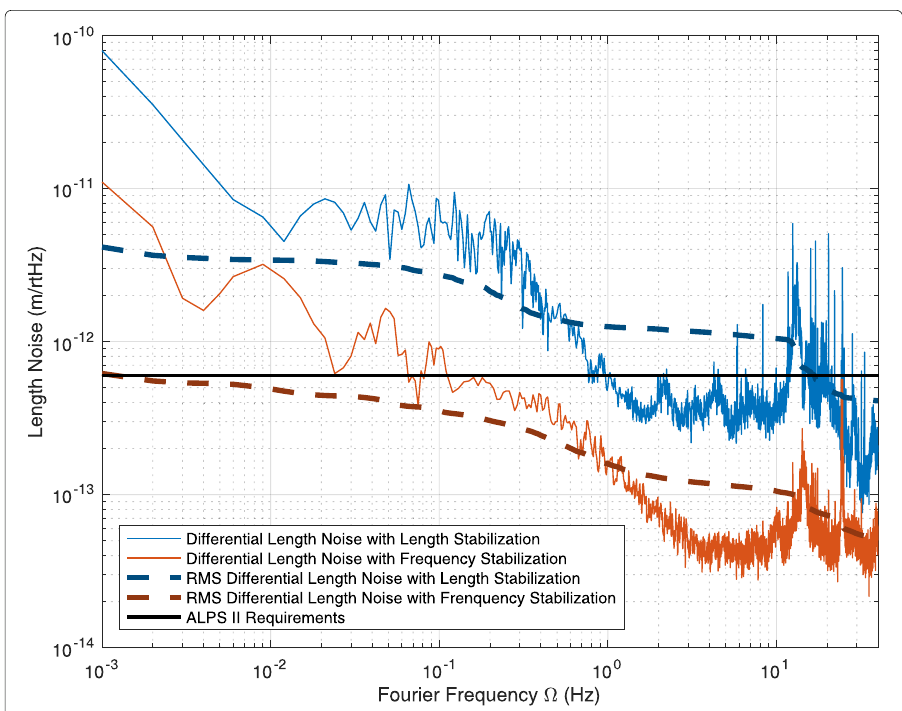
Fig. 4 Out-of-loop measurement. Beatnote frequency measurement for the length (solid blue trace) and frequency (solid red trace) feedback and corresponding RMS filtered by the infrared RC cavity pole for ALPS